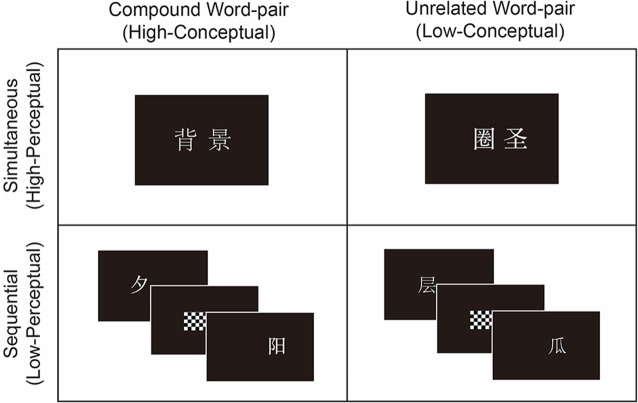
Example stimuli. In the high perceptual association condition, compound word-pairs (e.g., “” meaning “back-ground”) and unrelated word-pairs (e.g., “ ” meaning “circle-sage”) were presented simultaneously as high perceptual-high conceptual (HP-HC) and high perceptual-low conceptual (HP-LC) conditions respectively. In the low perceptual association condition, compound word-pairs (e.g., “ ” meaning “sun-set”) and unrelated word-pairs (e.g., “ ” meaning “layer-melon”) were presented sequentially as low perceptual-high conceptual (LP-HC) and low perceptual-low conceptual (LP-LC) conditions, respectively.